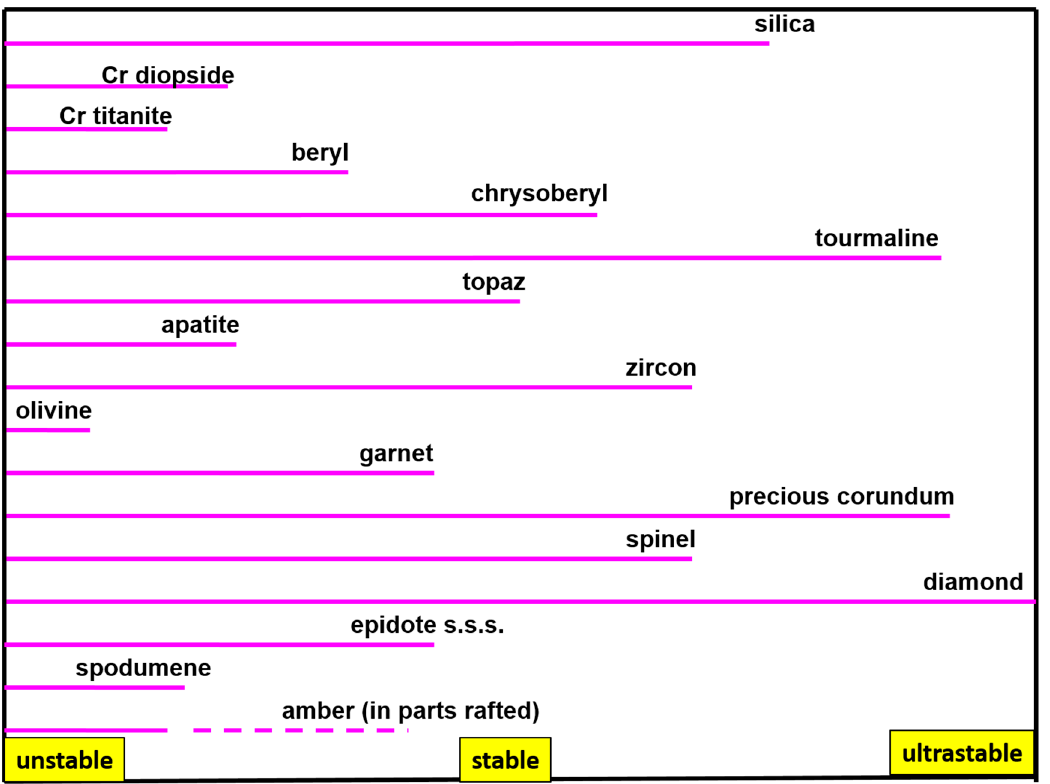
Figure 8. Relative stability of gemstones in placer deposits against attrition and weathering (data from (Morton and Dill [44,46–48])).